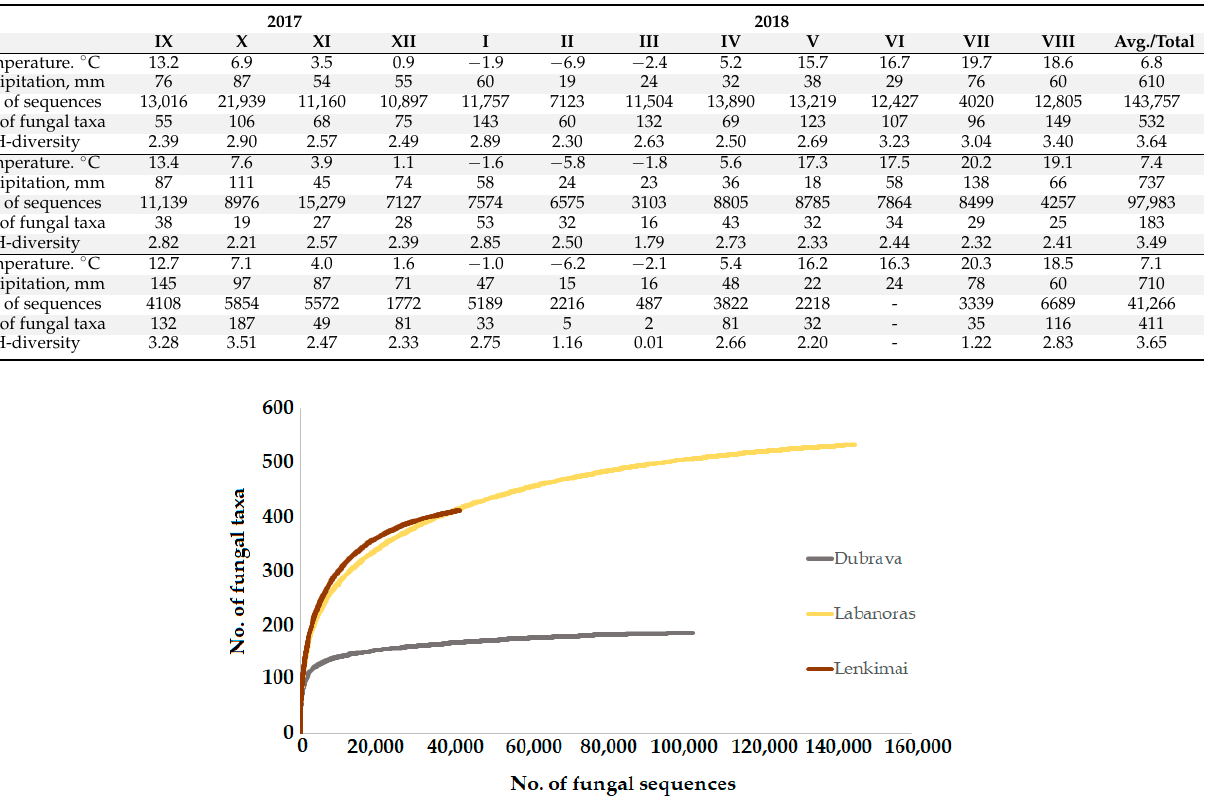
Table 1. Generated high-quality fungal sequences and detected diversity of fungal taxa in spore trap samples from Labanoras, Dubrava, and Lenkimai sites in Lithuania. The temperature and precipitation data show average values for the sampling period. Shannon diversity index is denoted by H-diversity.